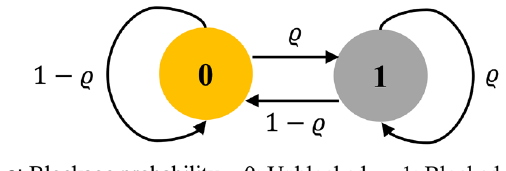
Fig. 1 The Markov chain-based blockage model X B ( t